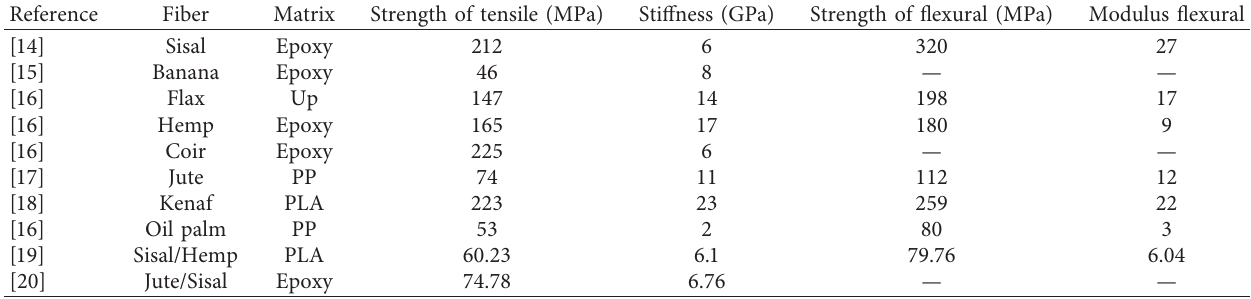
Table 1: List of various mechanical properties of natural fiber composites.